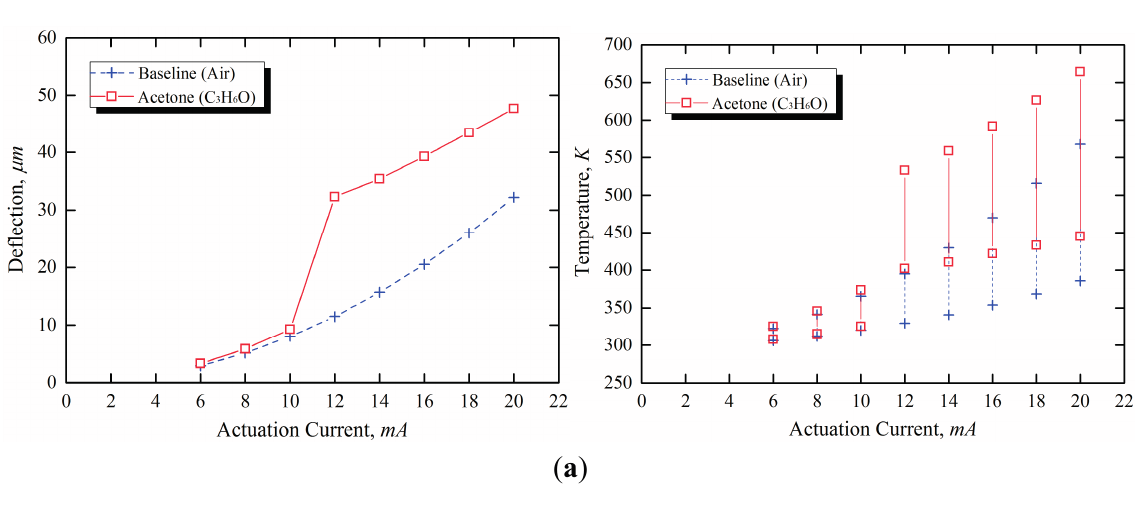
Figure 8. Surface temperature profile by nano-scale combustion reactions on the surface of the microcantilevers and bending response caused by bimetallic effect at 20 mA ( a ) acetone and ( b ) 2-propanol (note: translucent images represent the deflection in